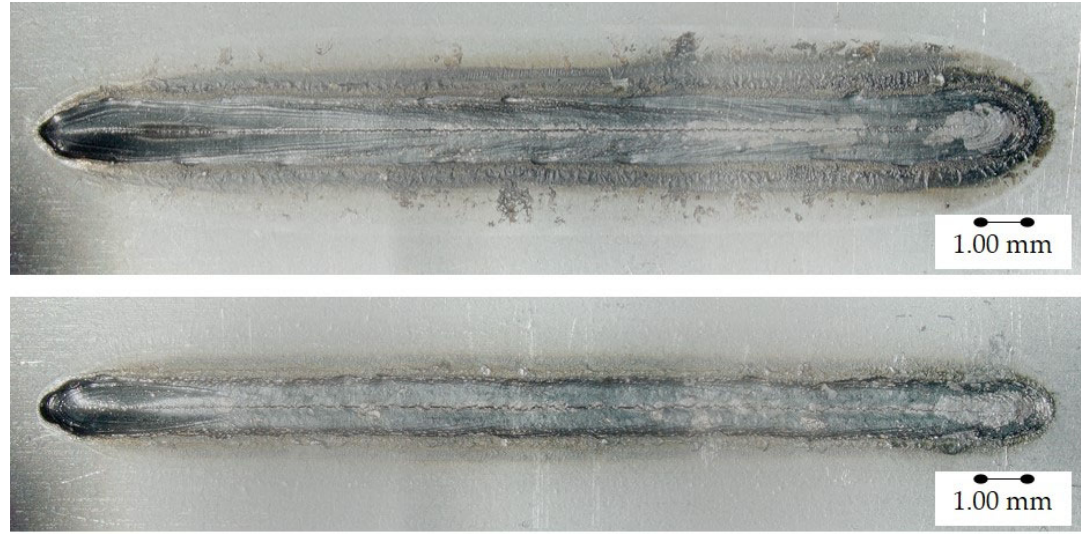
Figure 3. View of the weld crack from upside ( top ) and downside ( bottom ).